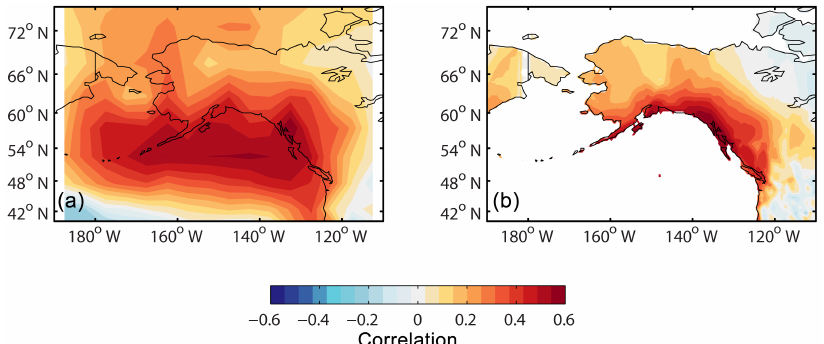
Figure 4. Spatial correlation (1901–1989) fields comparing the RW + DB GOA JJAS temperature reconstruction with larger-scale tempera- tures. (a) HADCRUT4 land and sea surface temperature (Morice et al., 2012; Cowtan and Way, 2014); (b) CRU TS 3.24 land temperatures (Harris et al., 2014).